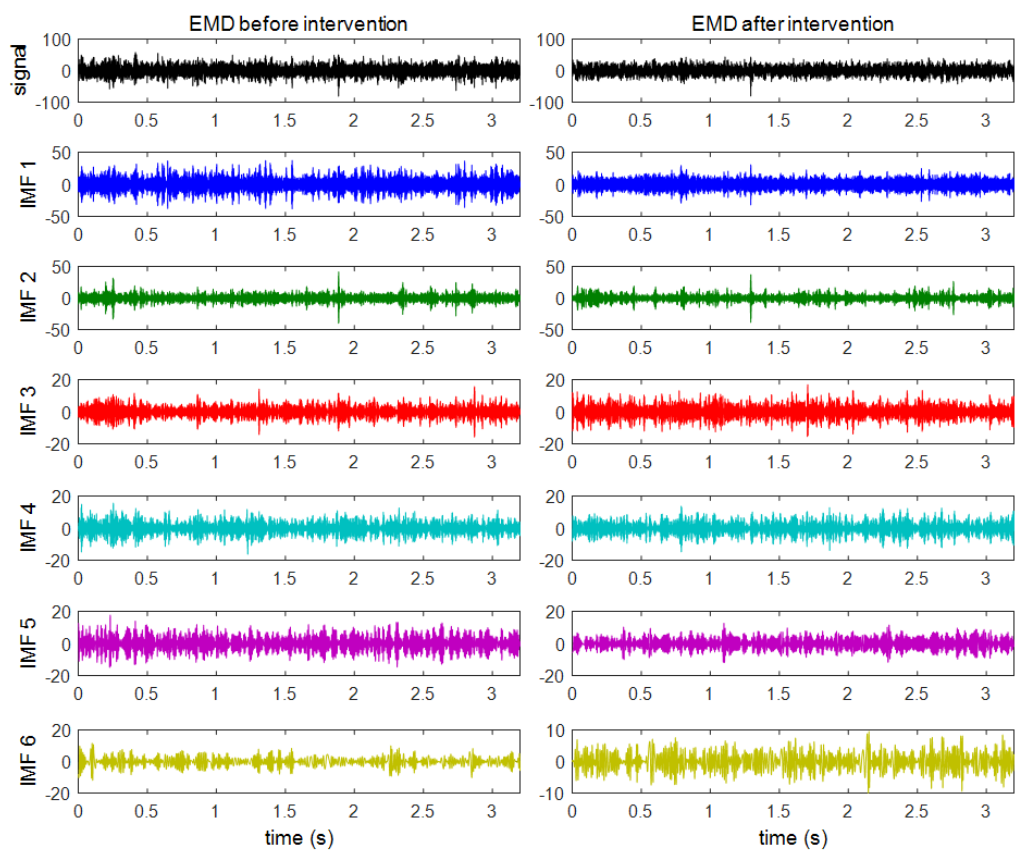
Figure 8. The original signal (in black) and the first six IMF (in different colours) of vertical vibration signals before and after maintenance.